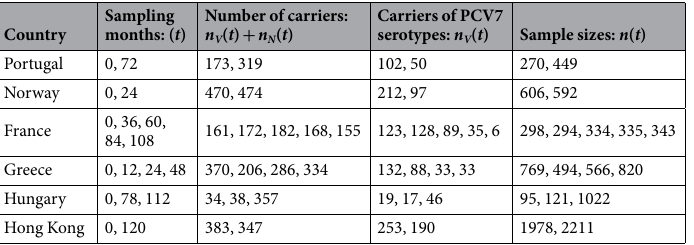
Carriers of PCV7 serotypes: n V ( t ) Sample sizes: n ( t )